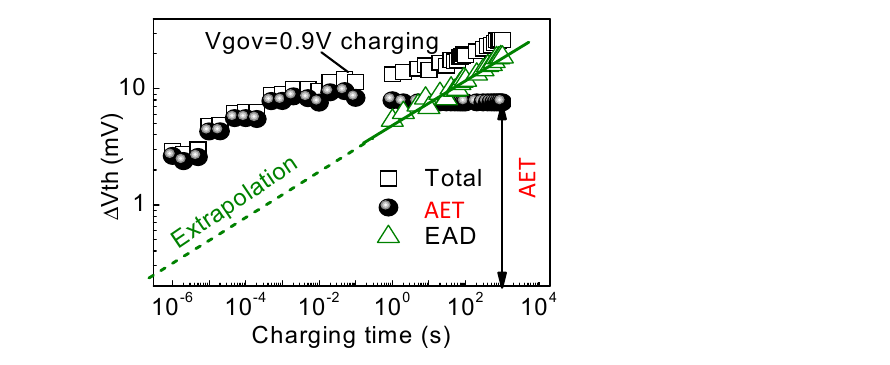
Figure 45. Extracting the kinetics of an EAD and an AET from the measured total Δ Vth [39]. The separated AET and EAD at different Vgov are given in Figure 46a,b, respectively. The power exponent of the EAD was insensitive to Vgov, and the AET followed the same kinetics after normalizing against their saturation level.